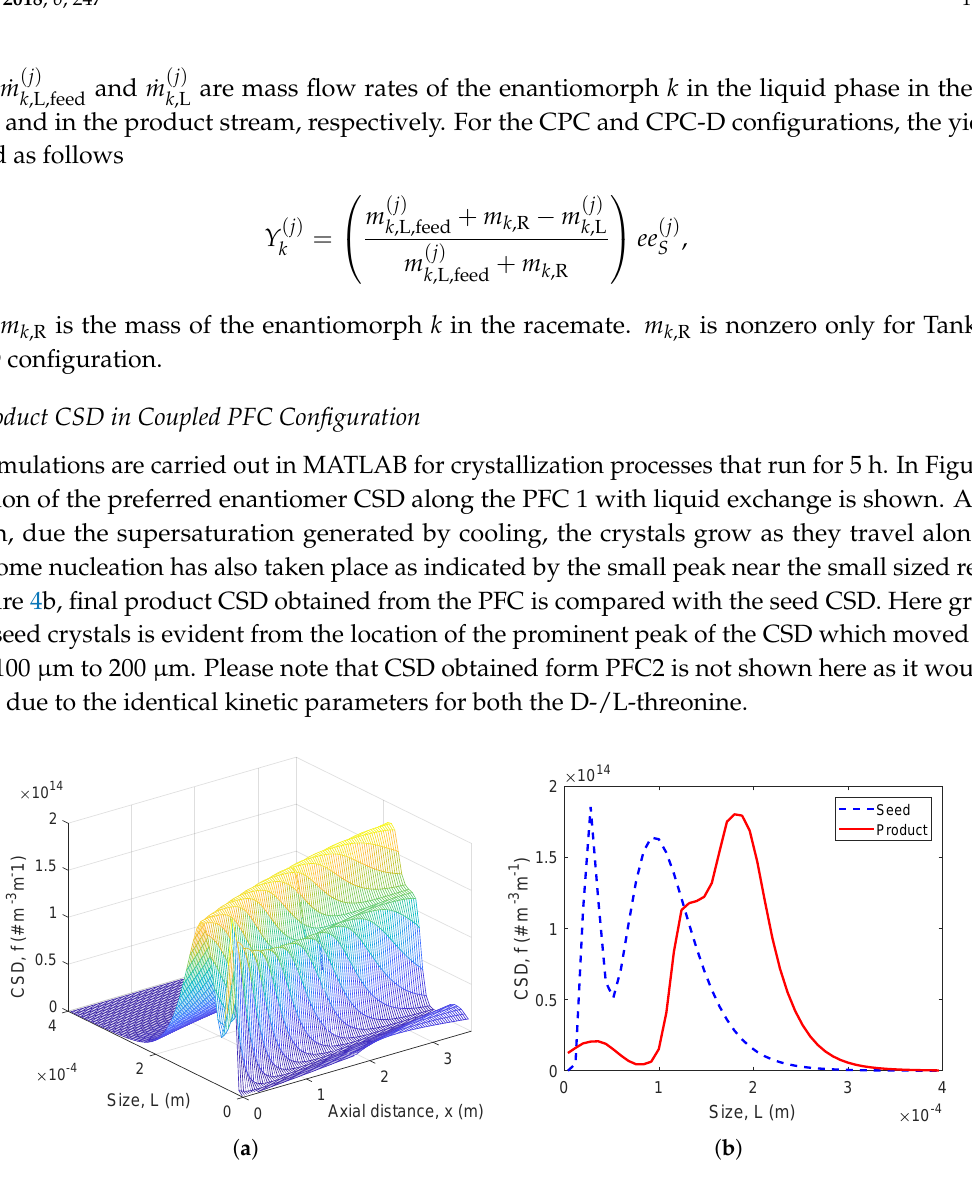
Figure 4. ( a ) Evolution of the CSD (Crystal size distribution) for E 1 along the PFC1 when liquid phase exchange is used, ( b ) Comparison of the product CSD for E 1 with the seed